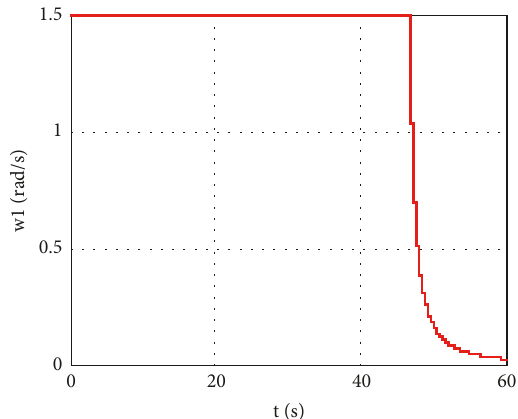
Figure 2: Time dependence of the robot right wheel coordinate.